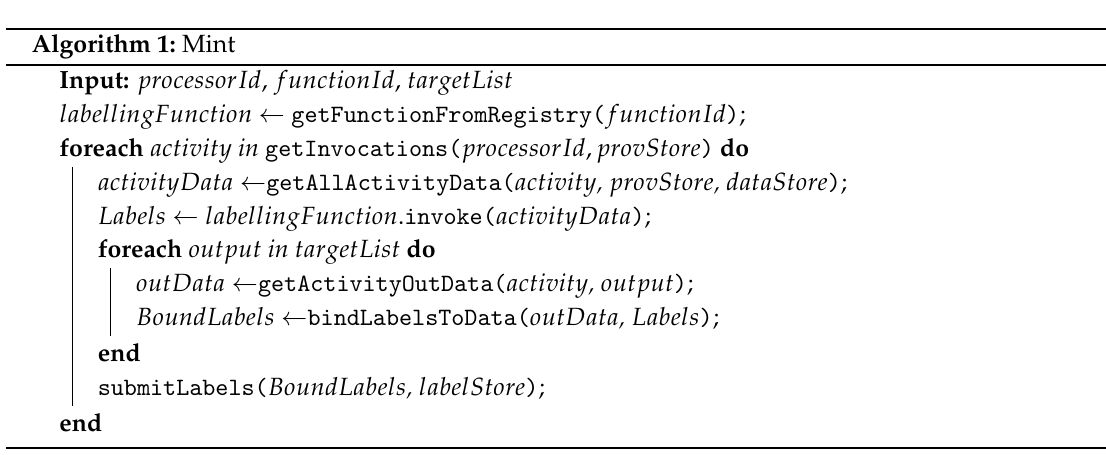
Figure 9. Mint Operator